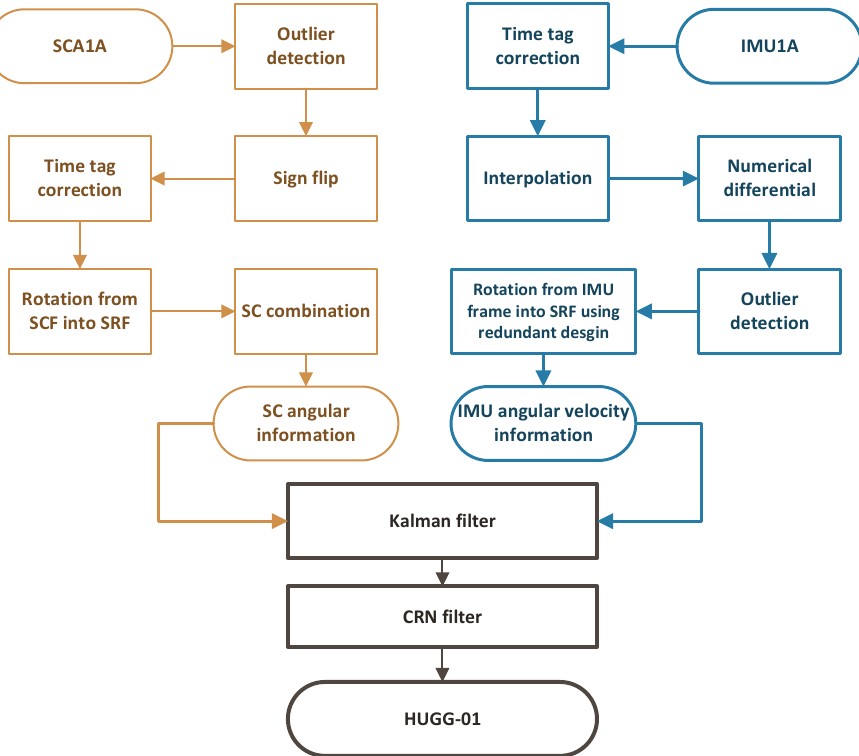
Figure 1. Diagram of our attitude reconstruction scheme. Box in dark yellow represents the SC processing, and box in cyan represents the IMU processing. The stage of data fusion is marked in